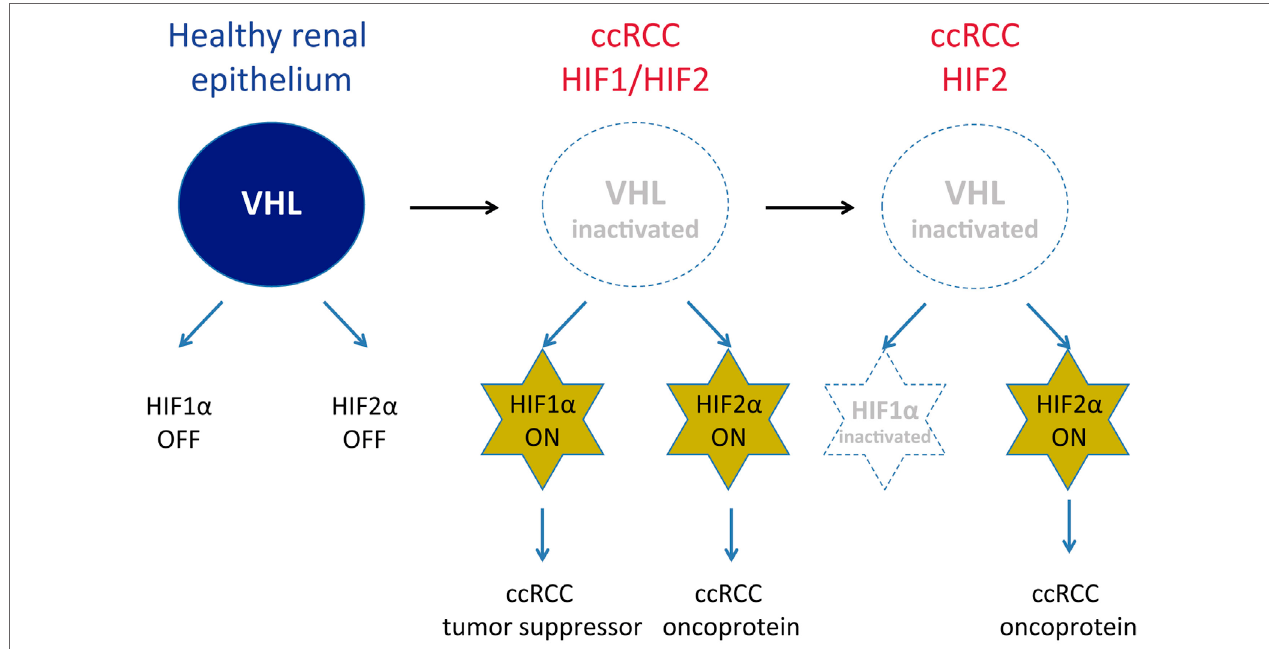
FigURe 1 | Expression of hypoxia-inducible factors (HIF)1 α and HIF2 α in Von Hippel–Lindau (VHL)-deficient clear cell renal cell carcinoma (ccRCC). The expression of VHL/E3 ubiquitin ligase complex leads to the proteasomal degradation of HIF α subunits, which assure that HIF1 α and HIF2 α inactivation in healthy renal epithelial cells. Upon VHL gene inactivation in ccRCC, HIF1 α and HIF2 α cannot be degraded and, therefore, are constitutively expressed in a large number of ccRCC. However, HIF1 α acts as a ccRCC tumor suppressor and in this line, HIF1 α locus is inactivated in some ccRCC while the expression of HIF2 α —acting as a ccRCC oncoprotein—persists in some other ccRCC